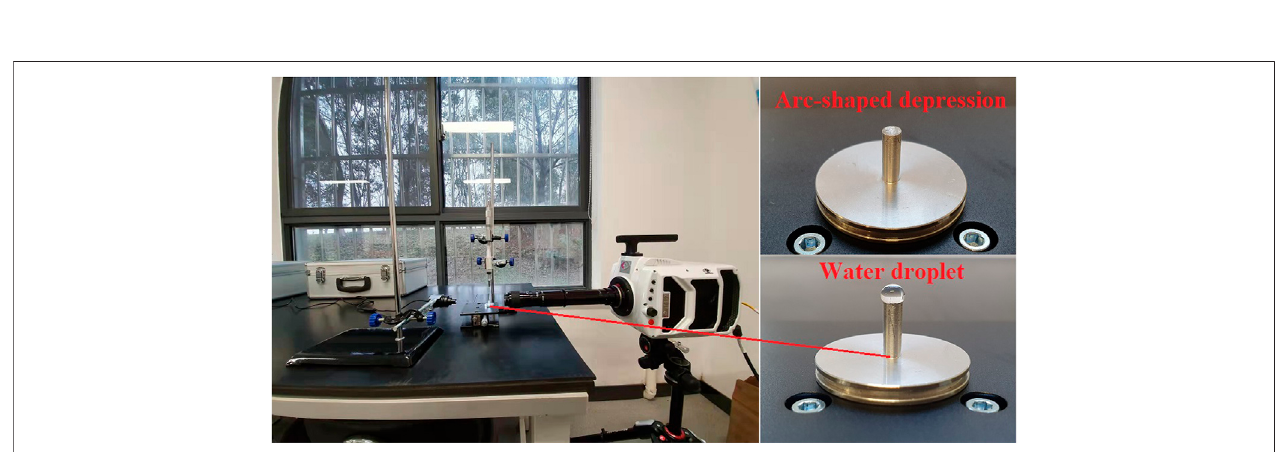
FIGURE 2 | Experimental apparatus set up, diagram of droplet stand and droplet, point light and high-speed camera to record the contacting phenomenon between dust particles and water droplet on the stand.